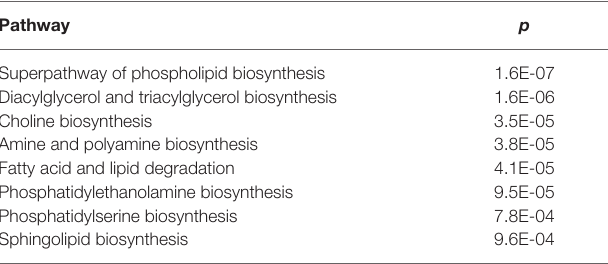
TABLE 2 | List of metabolic pathways involved in the response of maize plants to fumonisin accumulation. Pathway